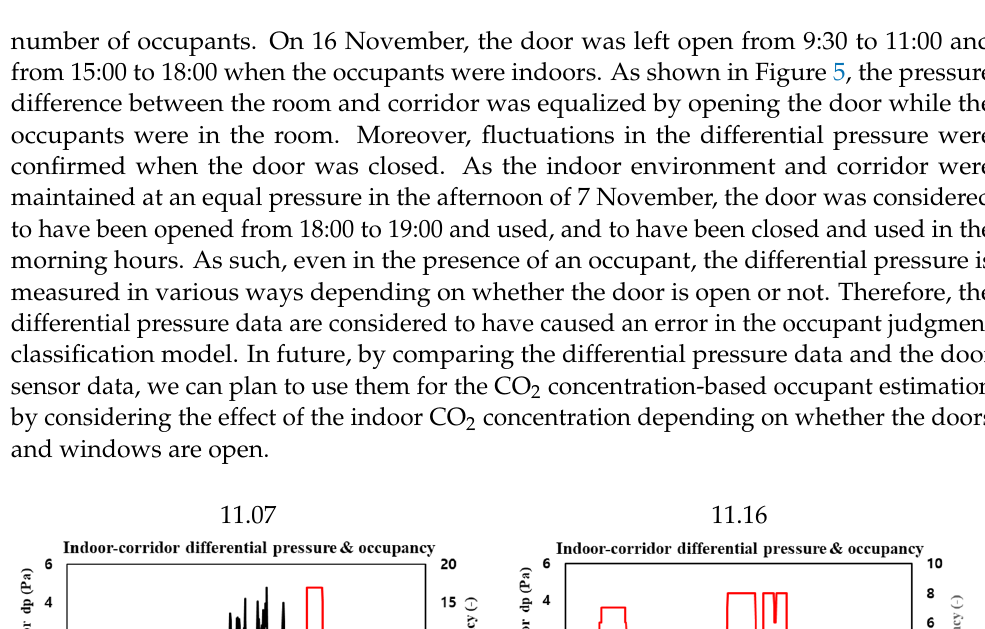
left. The RMSE of Case 4 in the ANN model is lower than that of Case 2 because Case 2 of the ANN model fits the occupancy range better than Case 4 throughout the study period.